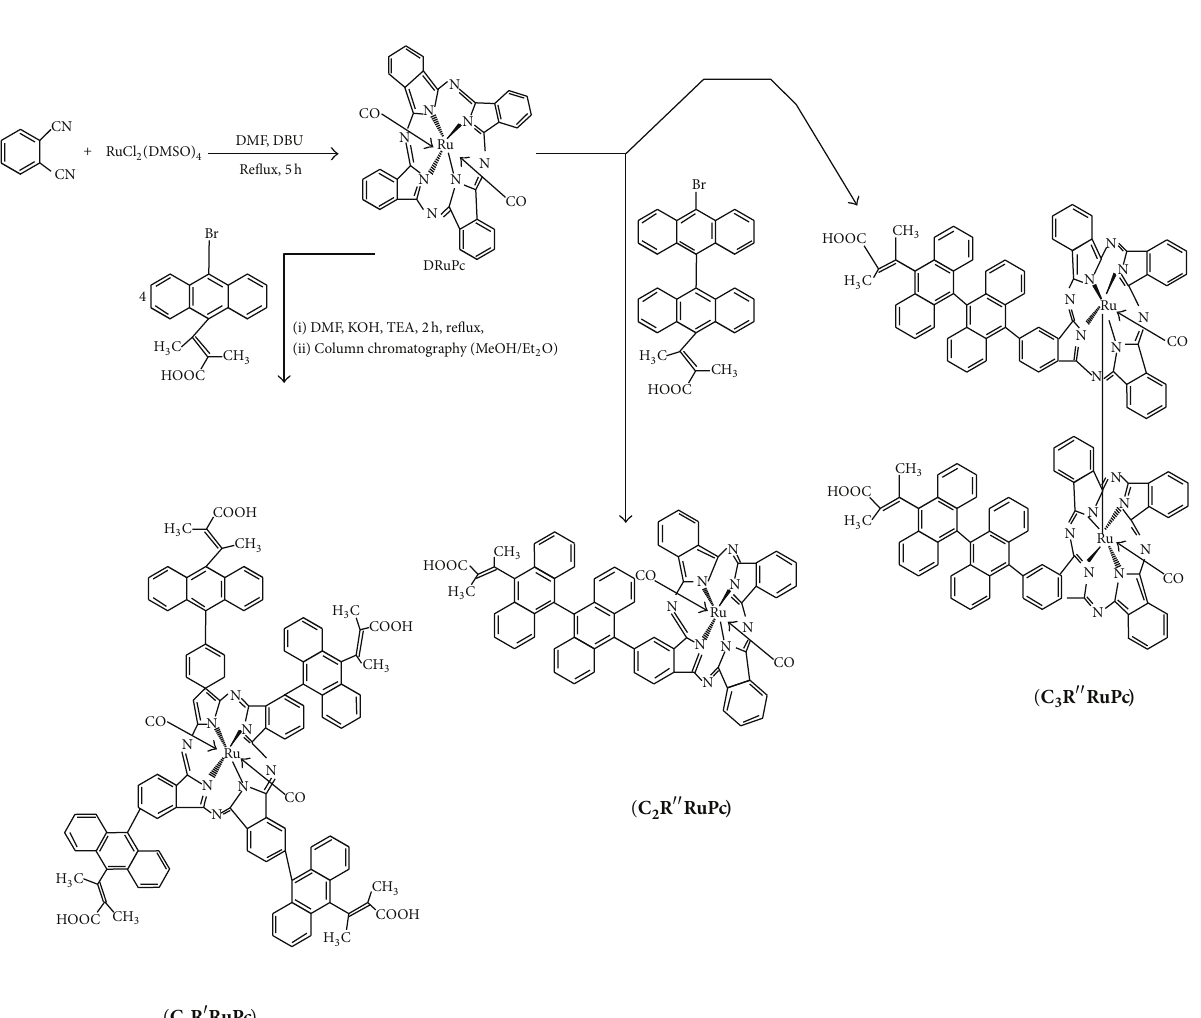
Scheme 1: Reaction scheme showing electrophilic substitution on